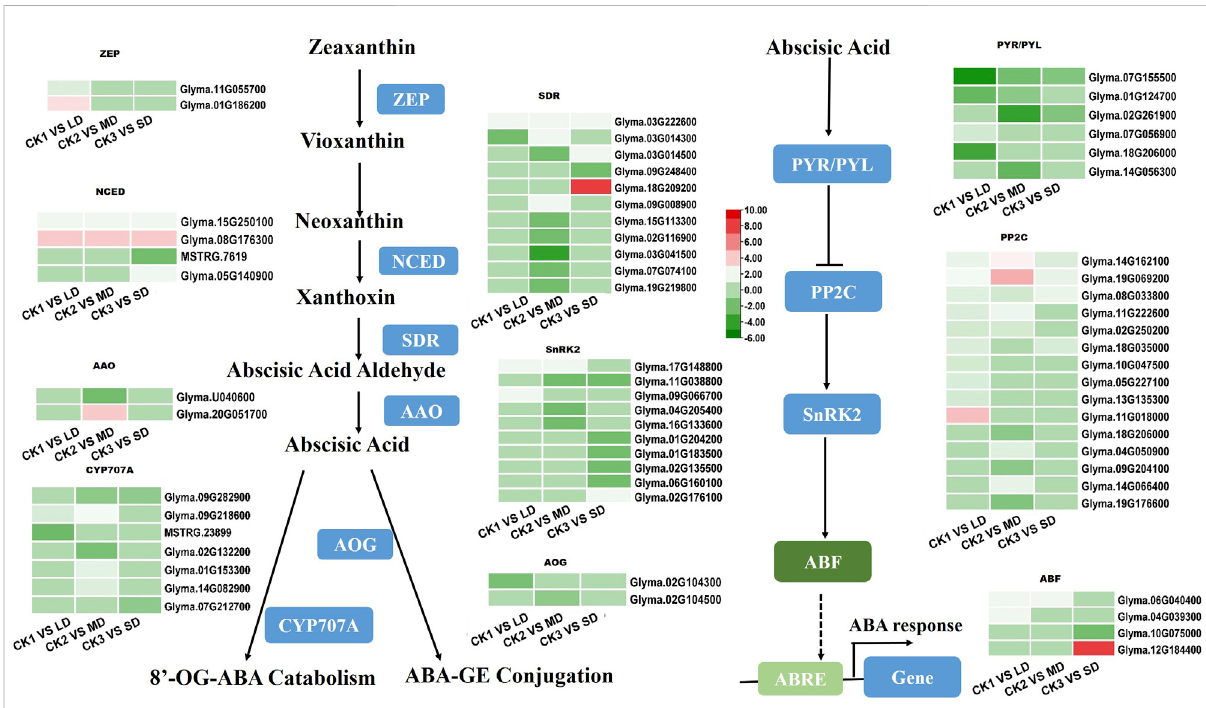
FIGURE 5 Heatmap of drought-responsive DEGs involved in ABA biosynthesis and signaling pathways under drought stress. The colors of heatmap vary from green to red by normalizing the log 2 (FPKM) of each